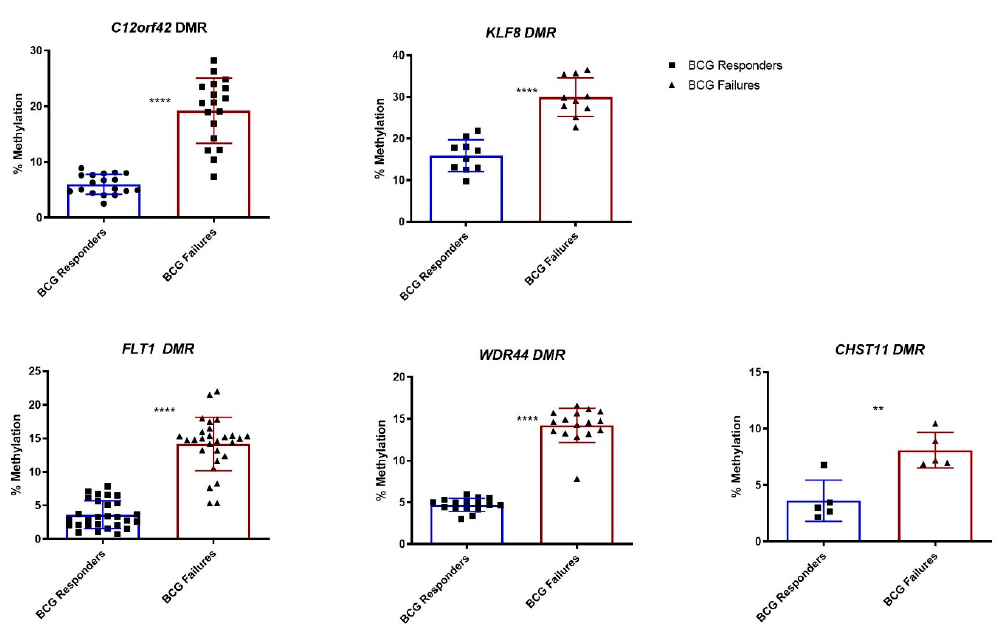
Figure 4. Comparison of overall DNA methylation percentage differences of the DMRs in the promoters of KLF8 , C12orf42 , WDR44 , FLT1, and CHST11 . Error bars indicate mean ± SD. Note that individual values represent average DNA methylation values of respective CpG sites within the promoters. **: p -value < 0.01, ****: p -value < 0.0001. 3.5. GRP158 Shows a Higher Degree of Methylation in Patients with BCG Failure